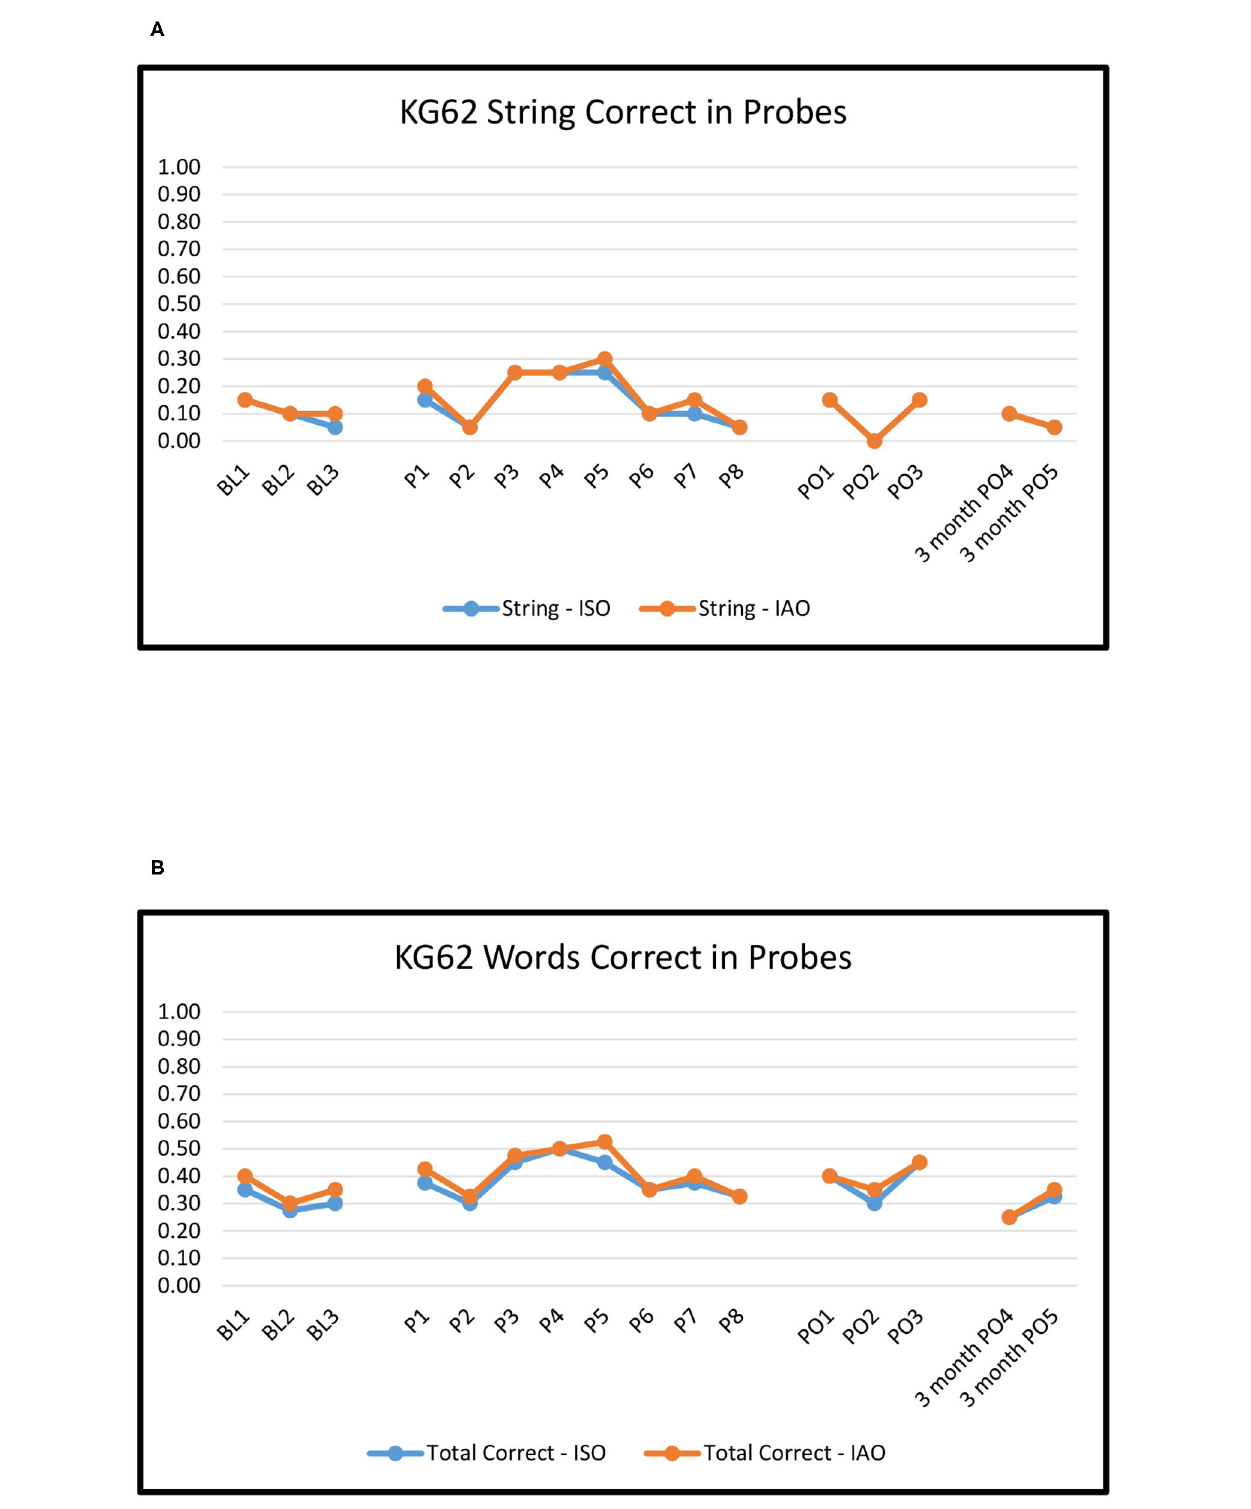
FIGURE 4 | KG62: Proportion of word strings (A) and words (B) correct in baseline, treatment, post-treatment, and 3 months follow-up probes.